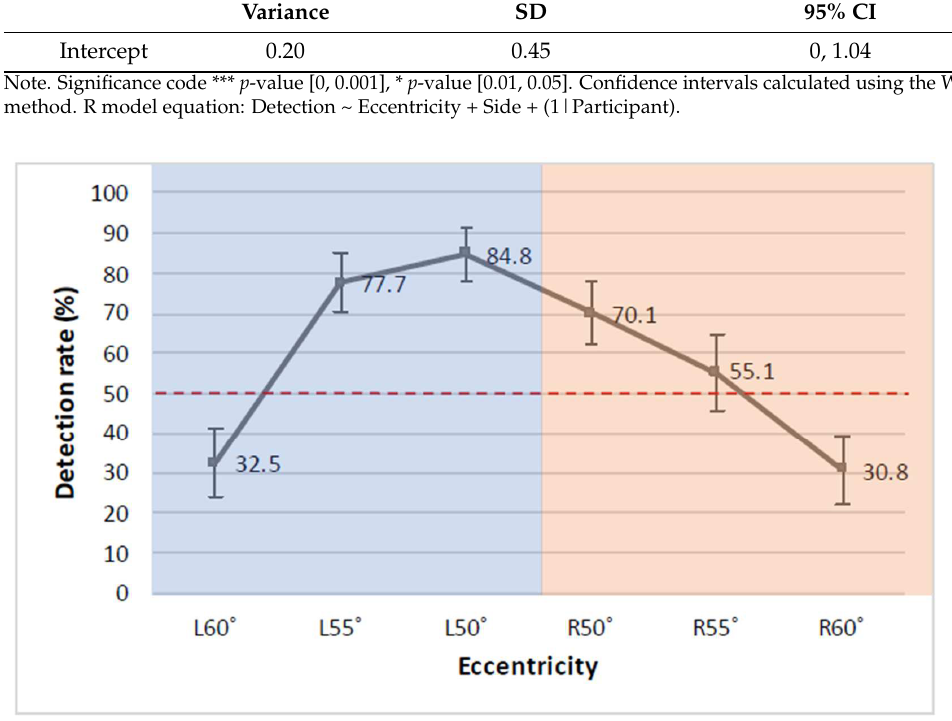
Table 1. The generalised linear mixed effects model (GLMM) results.